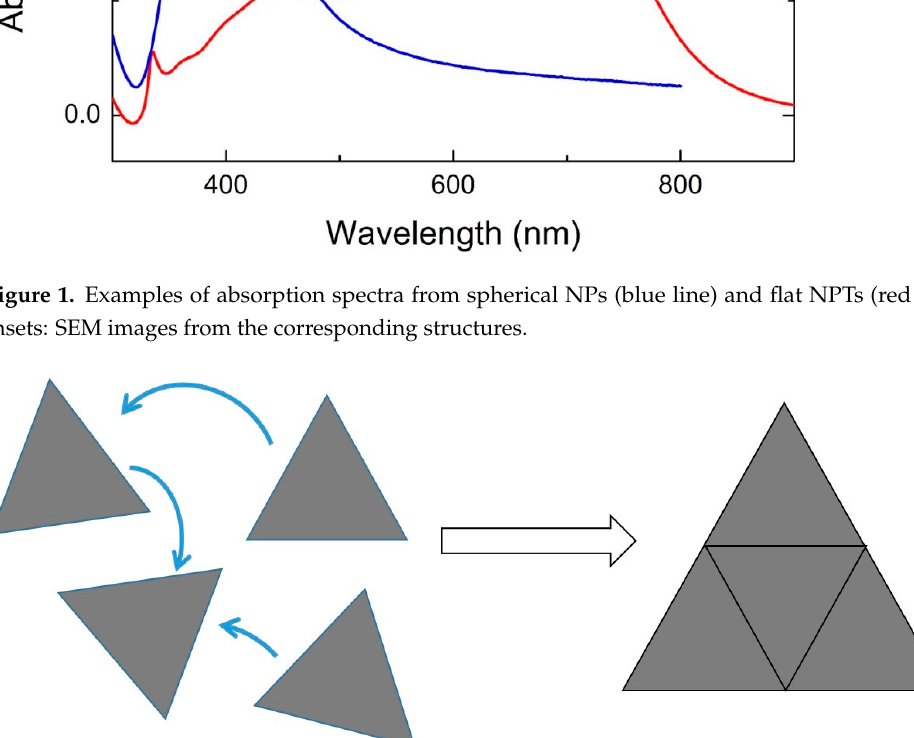
Figure 2. Schematic mechanism for the formation of larger nanoplates yielding a bimodal distribution in ref. [14] .